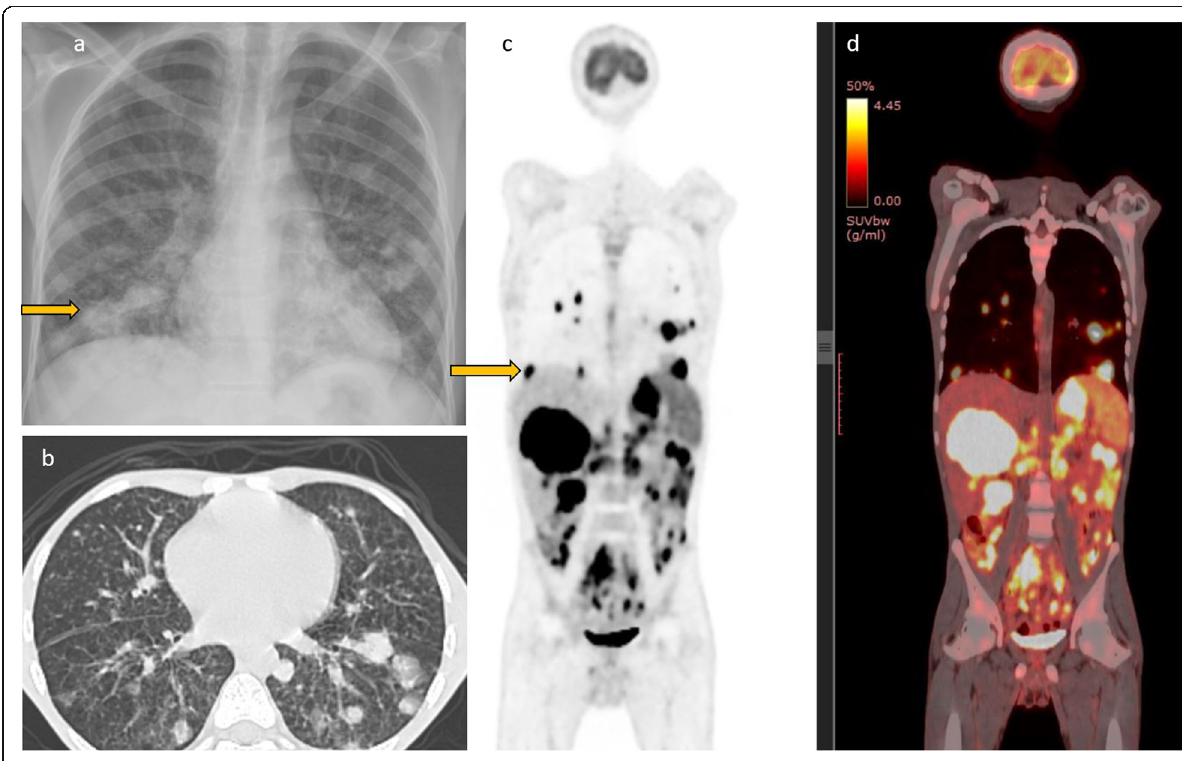
Fig. 1 Chest radiograph of a 19-year-old HIV-positive patient with low CD4 count. He presented with cough and dyspnea and was initially being evaluated for possible atypical pneumonia. The chest radiograph showed multiple focal opacities predominantly in the lower lung zones. On CT, there were lung parenchymal nodules/masses of variable sizes which were also intensely FDG avid on PET CT. There was extensive lymphoma involvement elsewhere including in the liver, spleen (splenic activity higher than liver background), and multiple nodal sites above and below the diaphragm. Biopsy of the liver lesion was consistent with